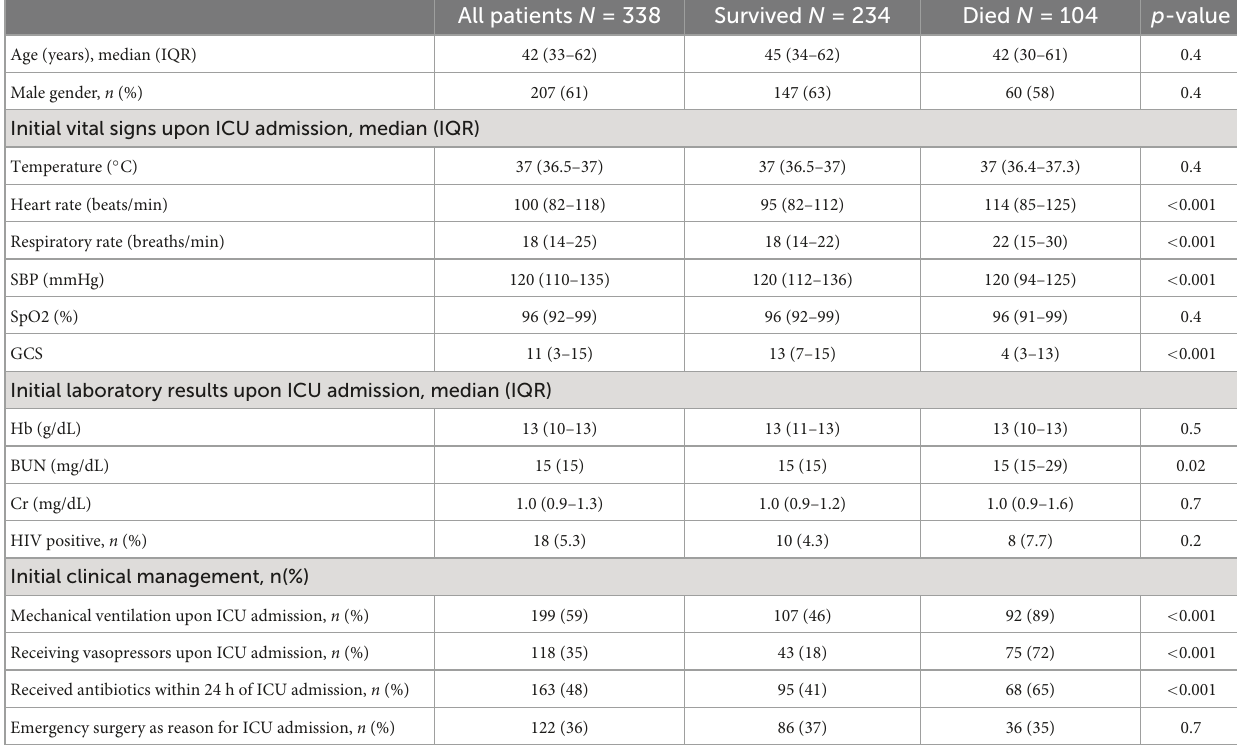
TABLE 1 Patient characteristics.